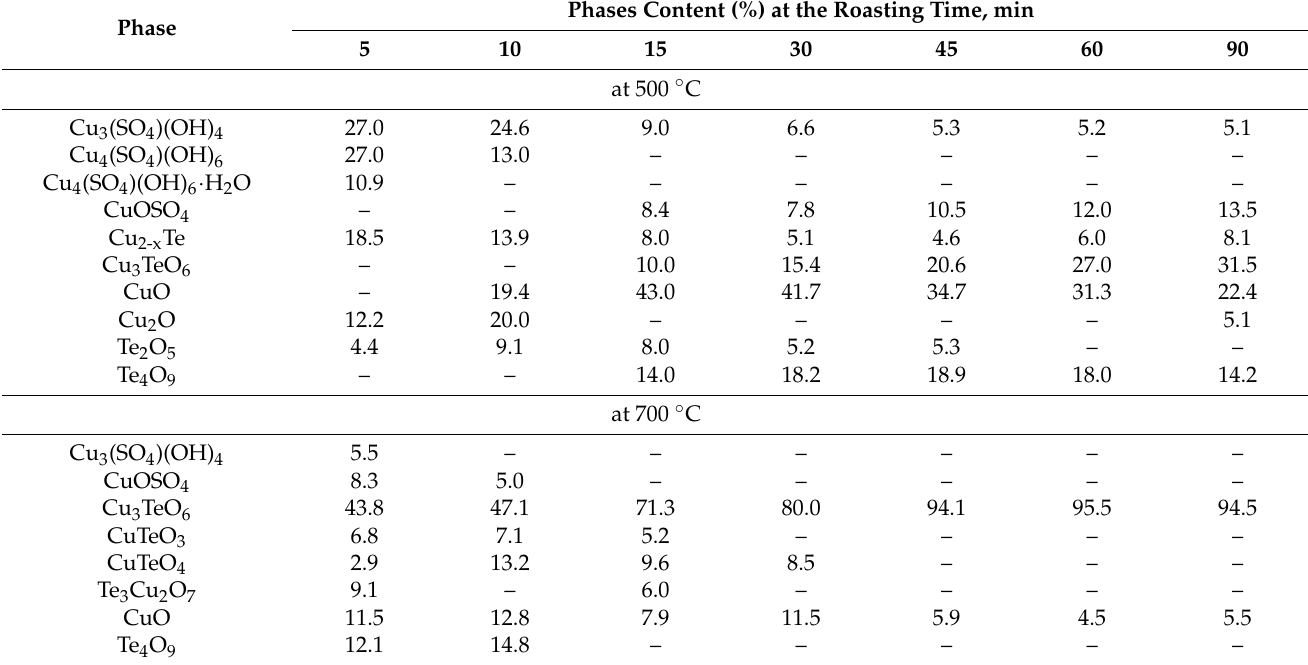
Table 2. Phase composition (wt%) of low-temperature roasting residues (for Figures 4 and 5 (here- inafter, the quantitative analysis is given without considering the unknown phase,